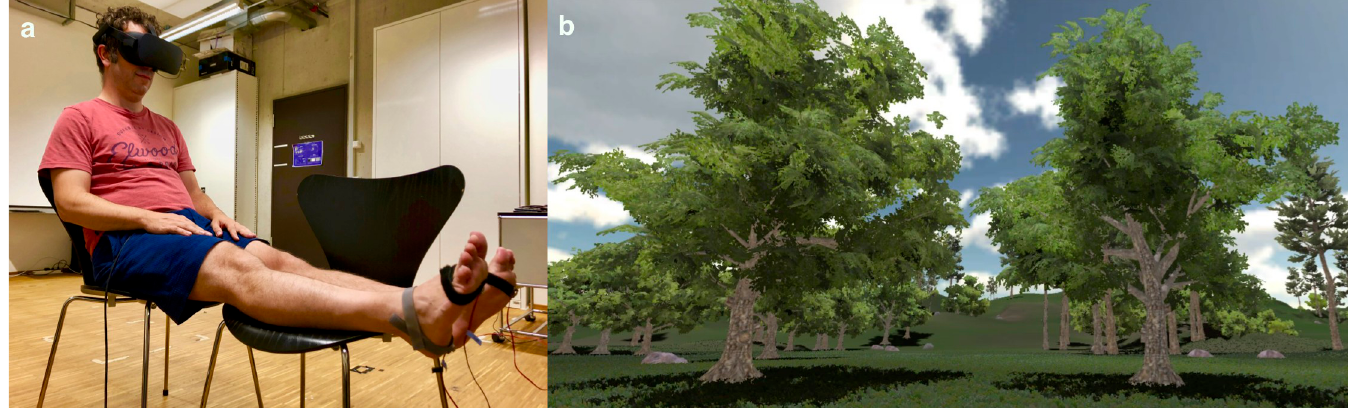
Fig 1. The experimental setup. (a) Seated male participant, with two vibratory devices attached to the sole of each foot, wearing a head-mounted display, via which he is being exposed to (b) a life-sized 3D virtual environment in which his virtual perspective while swaying like the head of a walking human was first moving forward across a meadow and then up a